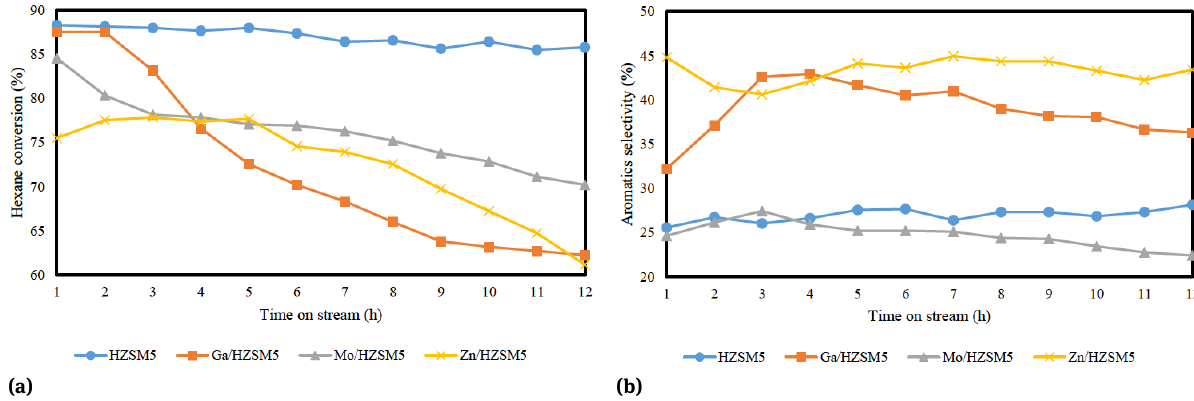
Figure 6: The catalytic conversion of n-hexane over metal promoted HZSM-5 catalysts of 2 wt.% loading as the function of time-on-stream at 500 ∘ C [61] Table 9: The results of physical adsorption with N2 of the catalysts [60] Sample